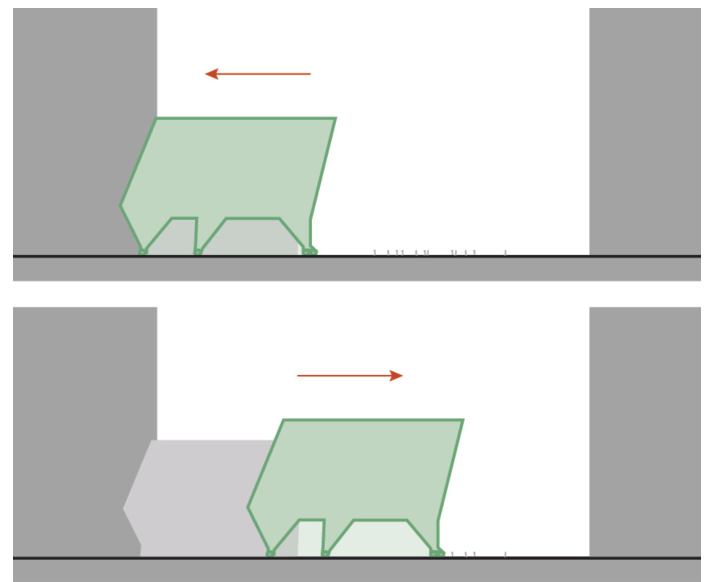
Figure 2. The retractable cubature of The Shed, NYC, 2019.